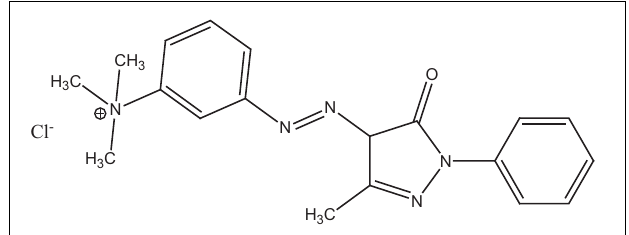
FIGURE 1 | Chemical structure of the cationic dye Basic Yellow 57 (BY57).